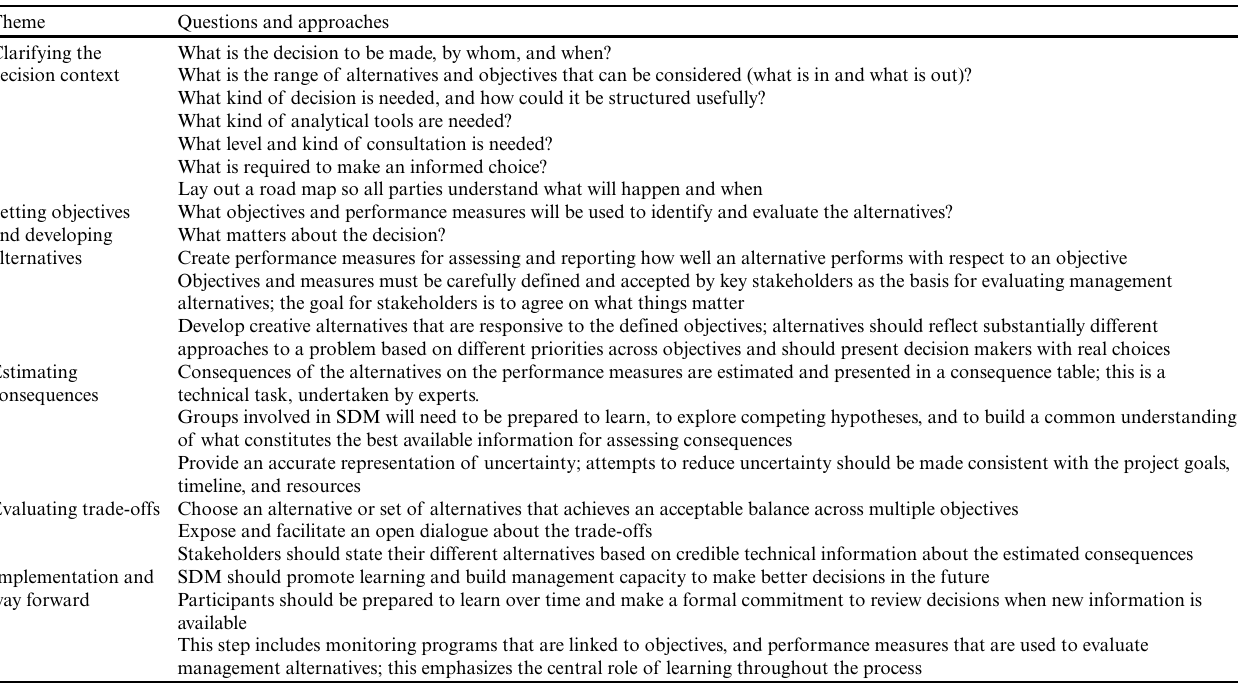
Table 1. Themes and questions or approaches involved in structured decision making (SDM). Source: adapted from Gregory et al.